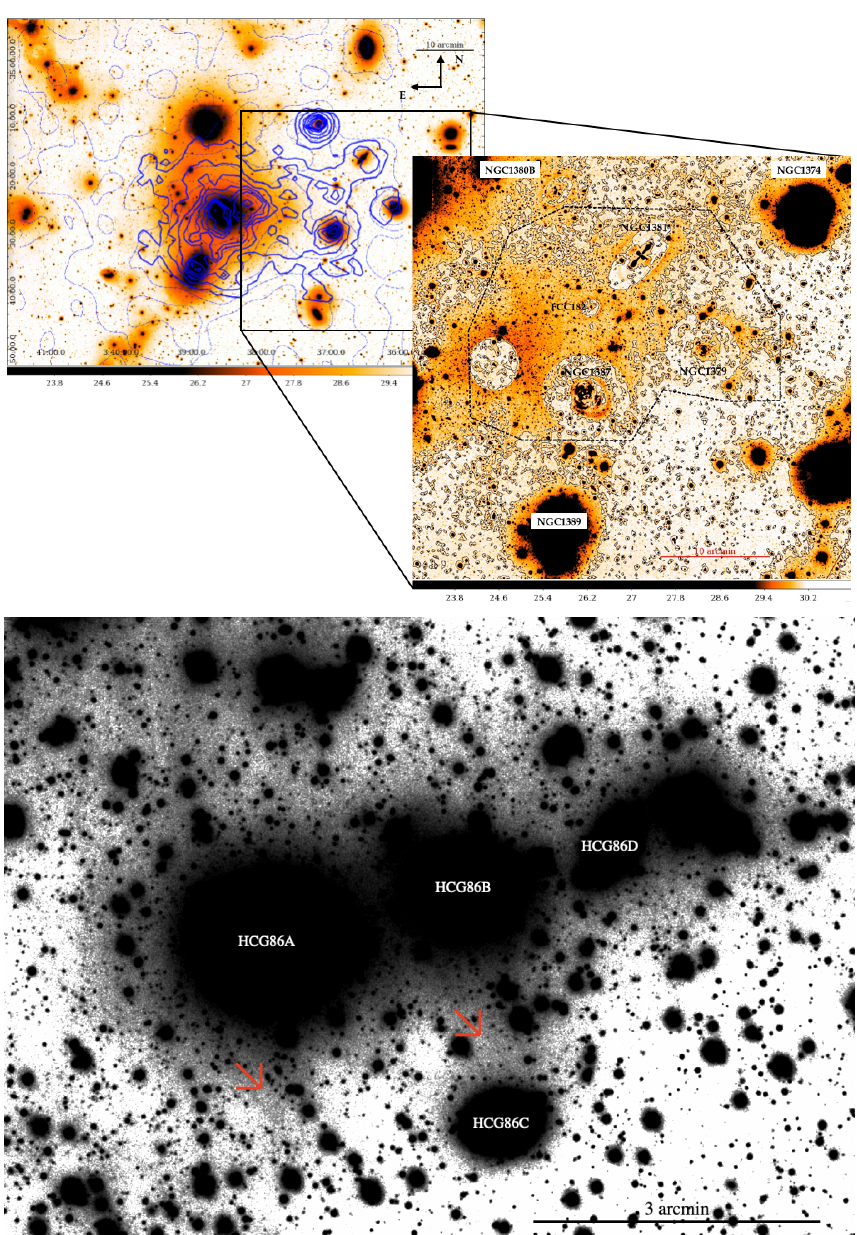
Figure 1. Top panel: An example of ICL in the Fornax cluster in r -band. Left panel: The blue contours are the spatial distribution of the globular clusters derived by [35,98]. Right panel: zoom-in of the west side where it is possible to see how the ICL distributes in the intra-cluster space. Credit: Iodice et al. [75]. Bottom panel: a recent example of ICL (in this case intragroup light) in the HCG 86 group. The grey detection indicated also by red arrows is the detection of the diffuse light. Credit: Ragusa et al.